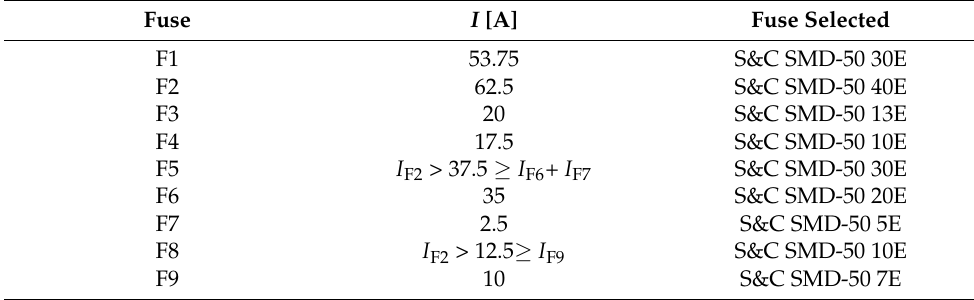
Table 4. Nominal currents of the fuses installed in the distribution network. Fuse